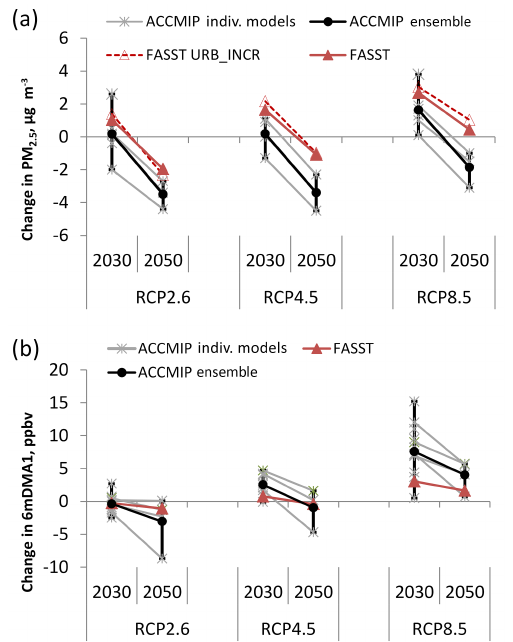
Figure 16. Global-population-weighted differences (scenario year minus the year 2000) (a) in annual mean PM 2 . 5 concentrations and (b) in O 3 exposure metric 6mDMA1 for three RCP scenarios in each future year, from the ACCMIP model ensemble (Silva et al., 2016) (black symbols and lines) and TM5-FASST_v0 (red symbols and lines). FASST URB_INCR includes the urban increment cor- rection. Grey symbols show results from individual ACCMIP mod- els. Grey lines connect results from a single model. Not all models have provided data for all scenarios. ACCMIP error bars represent the range (min, max) across the ACCMIP